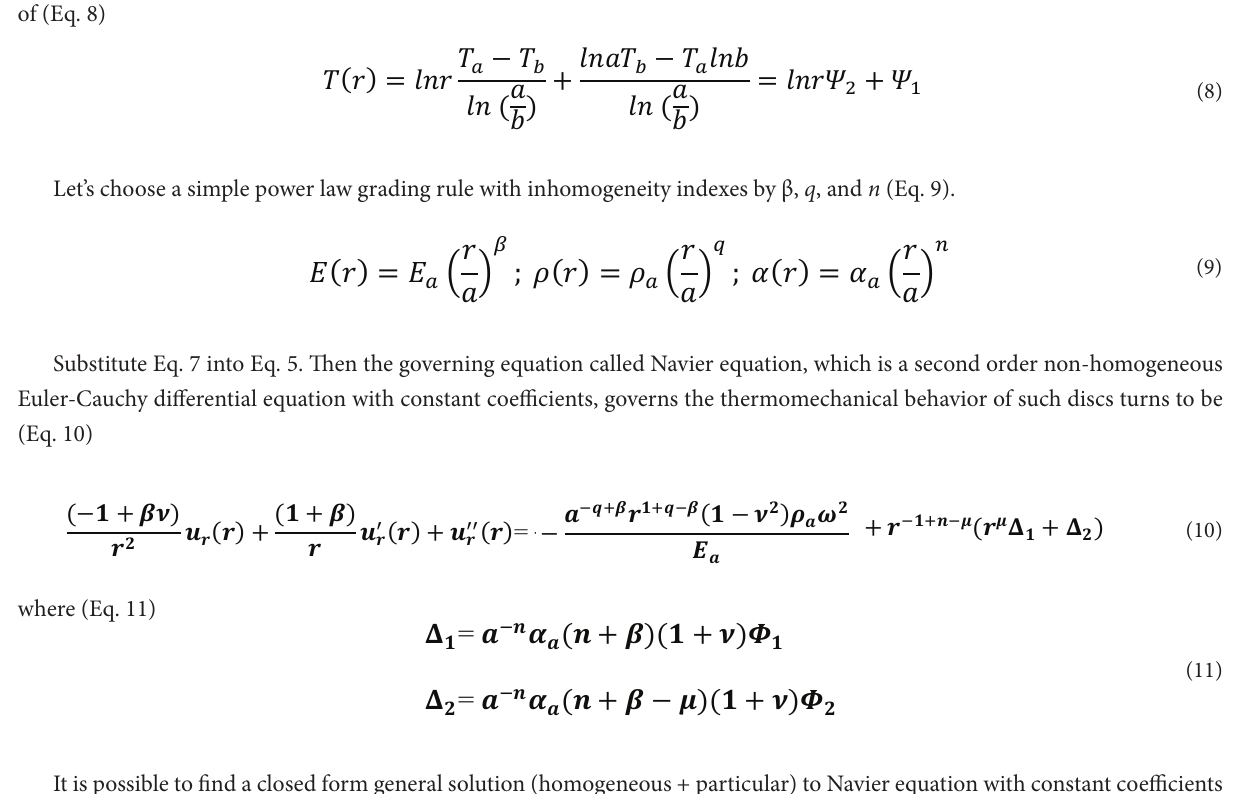
( r / a ) μ , as follows (Eq. 7) a